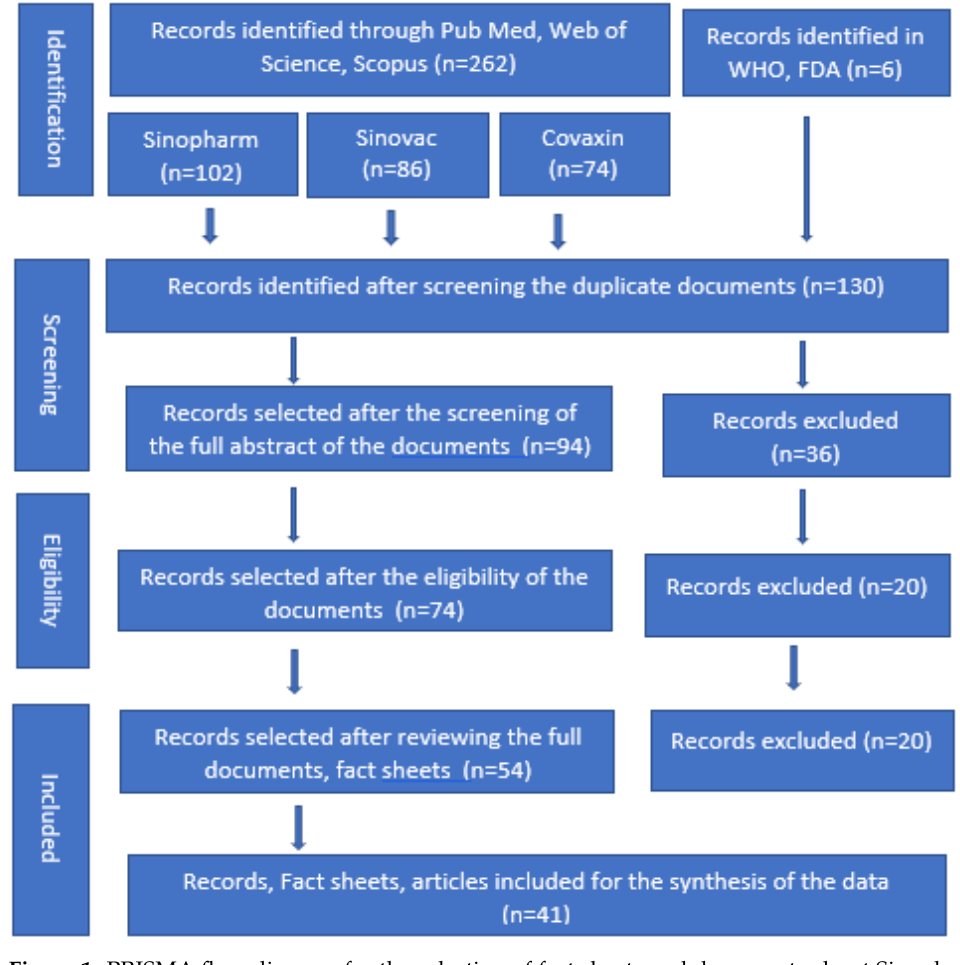
Table 1. Comparison of biological and pharmacological characteristics, indications, contra- indications, and mechanisms of action of the COVID-19 vaccines Sinopharm, CoronaVac, and Covaxin .